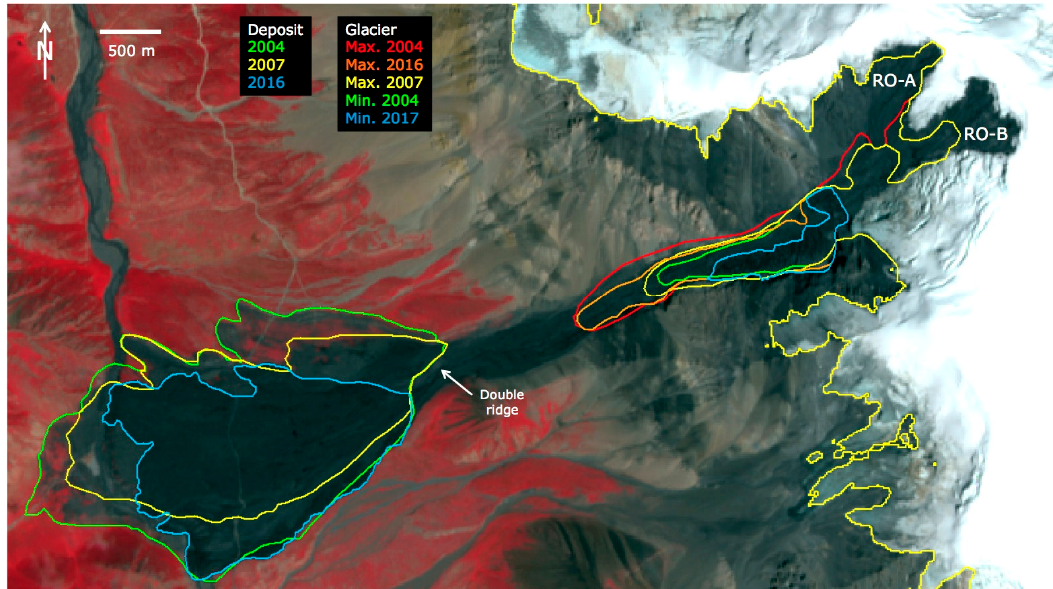
Figure 11. Extents of the deposits and glaciers for the three surges shown on the background of Figure 6d: Deposits from the 2004, 2007, and 2016 collapses are marked green, yellow, and blue, respectively. Maximum glacier extents (before the collapse) from 2004, 2007, and 2016 are shown in red, yellow, and orange, whereas minimum extents (after the collapse) from 2004 and 2017 are shown in green and blue, respectively. Image source: Copernicus Sentinel data 2017.